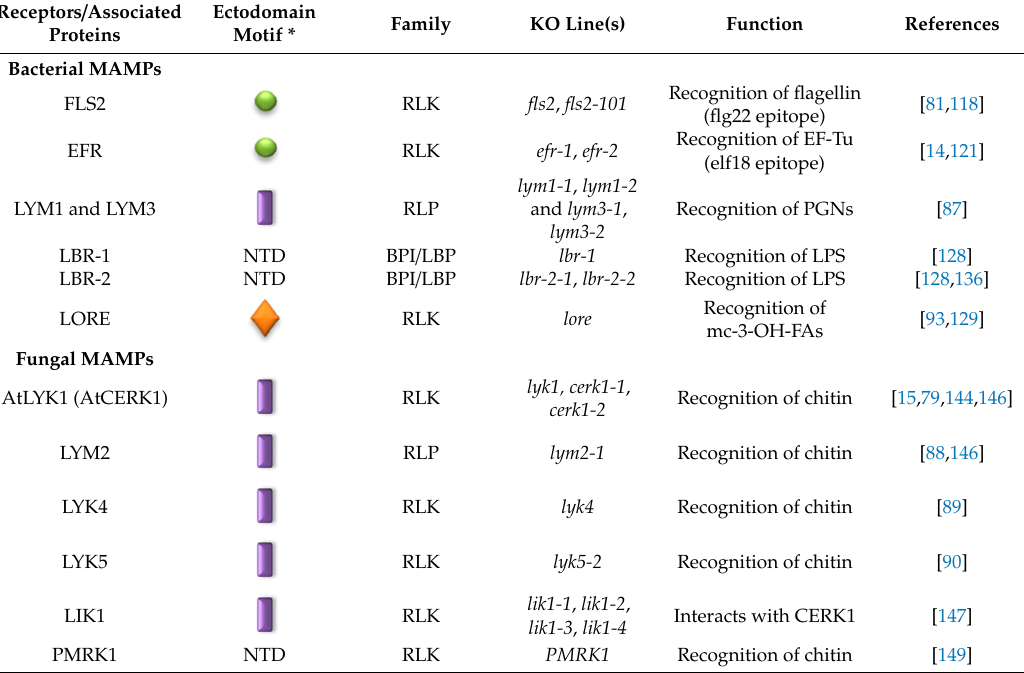
* Coloured symbols as defined in Figure 3. NTD = N-terminal